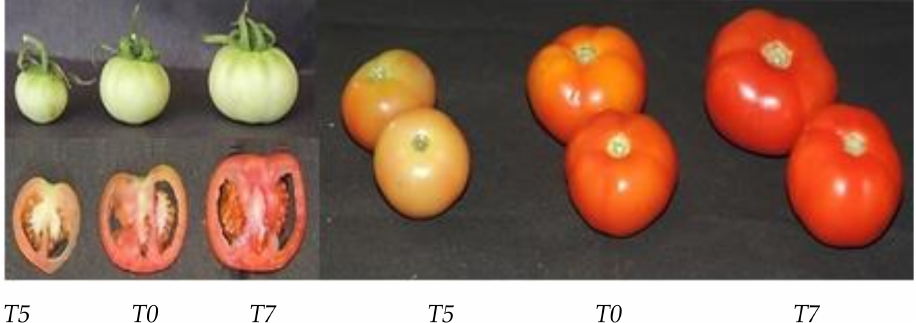
Figure 8. Effect of SWE on mitigating salt stress effects on fruit organolepty. (T0—Control, T5—S150 mM, T7—T5 + T6).